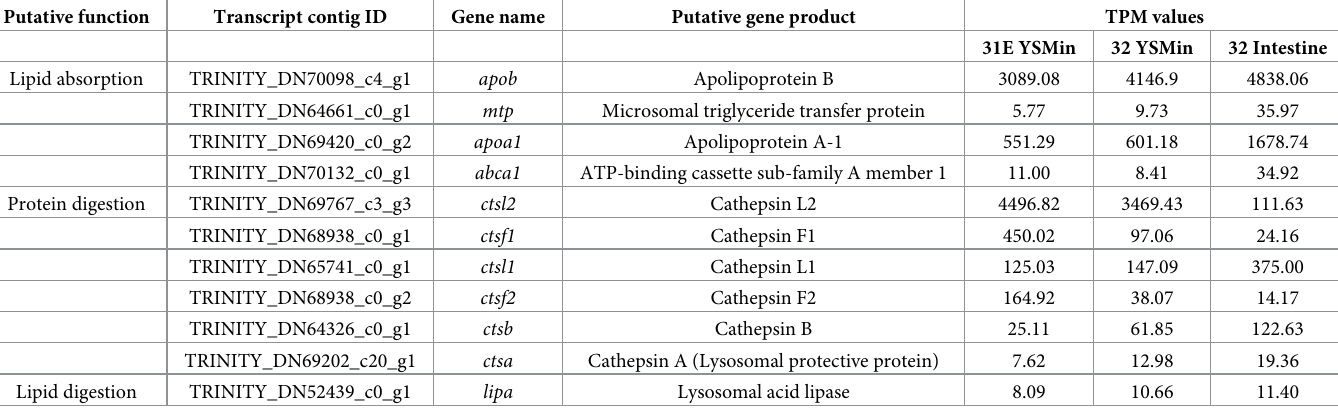
Table 2. Lipid absorption genes, cathepsin, and LIPA genes expressed in yolk sac membrane and intestine identified in transcriptome analysis. Putative